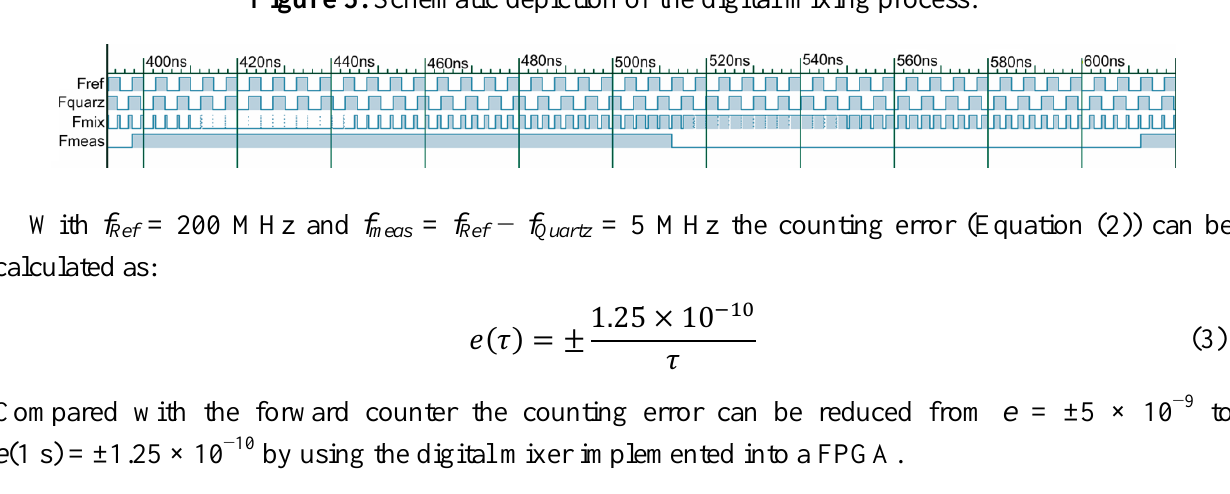
Figure 5. Schematic depiction of the digital mixing